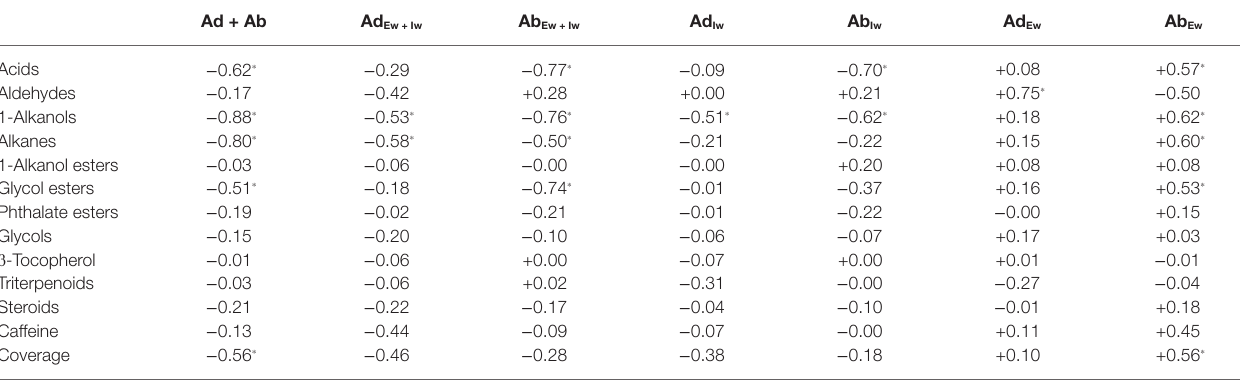
TABLE 1 | Correlation analysis between cuticular transpiration rate (or resistance) and cuticular wax chemical classes ( R 2 ).